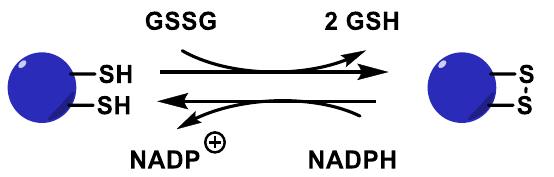
Figure 16. Glutathione reductase catalytic cycle.